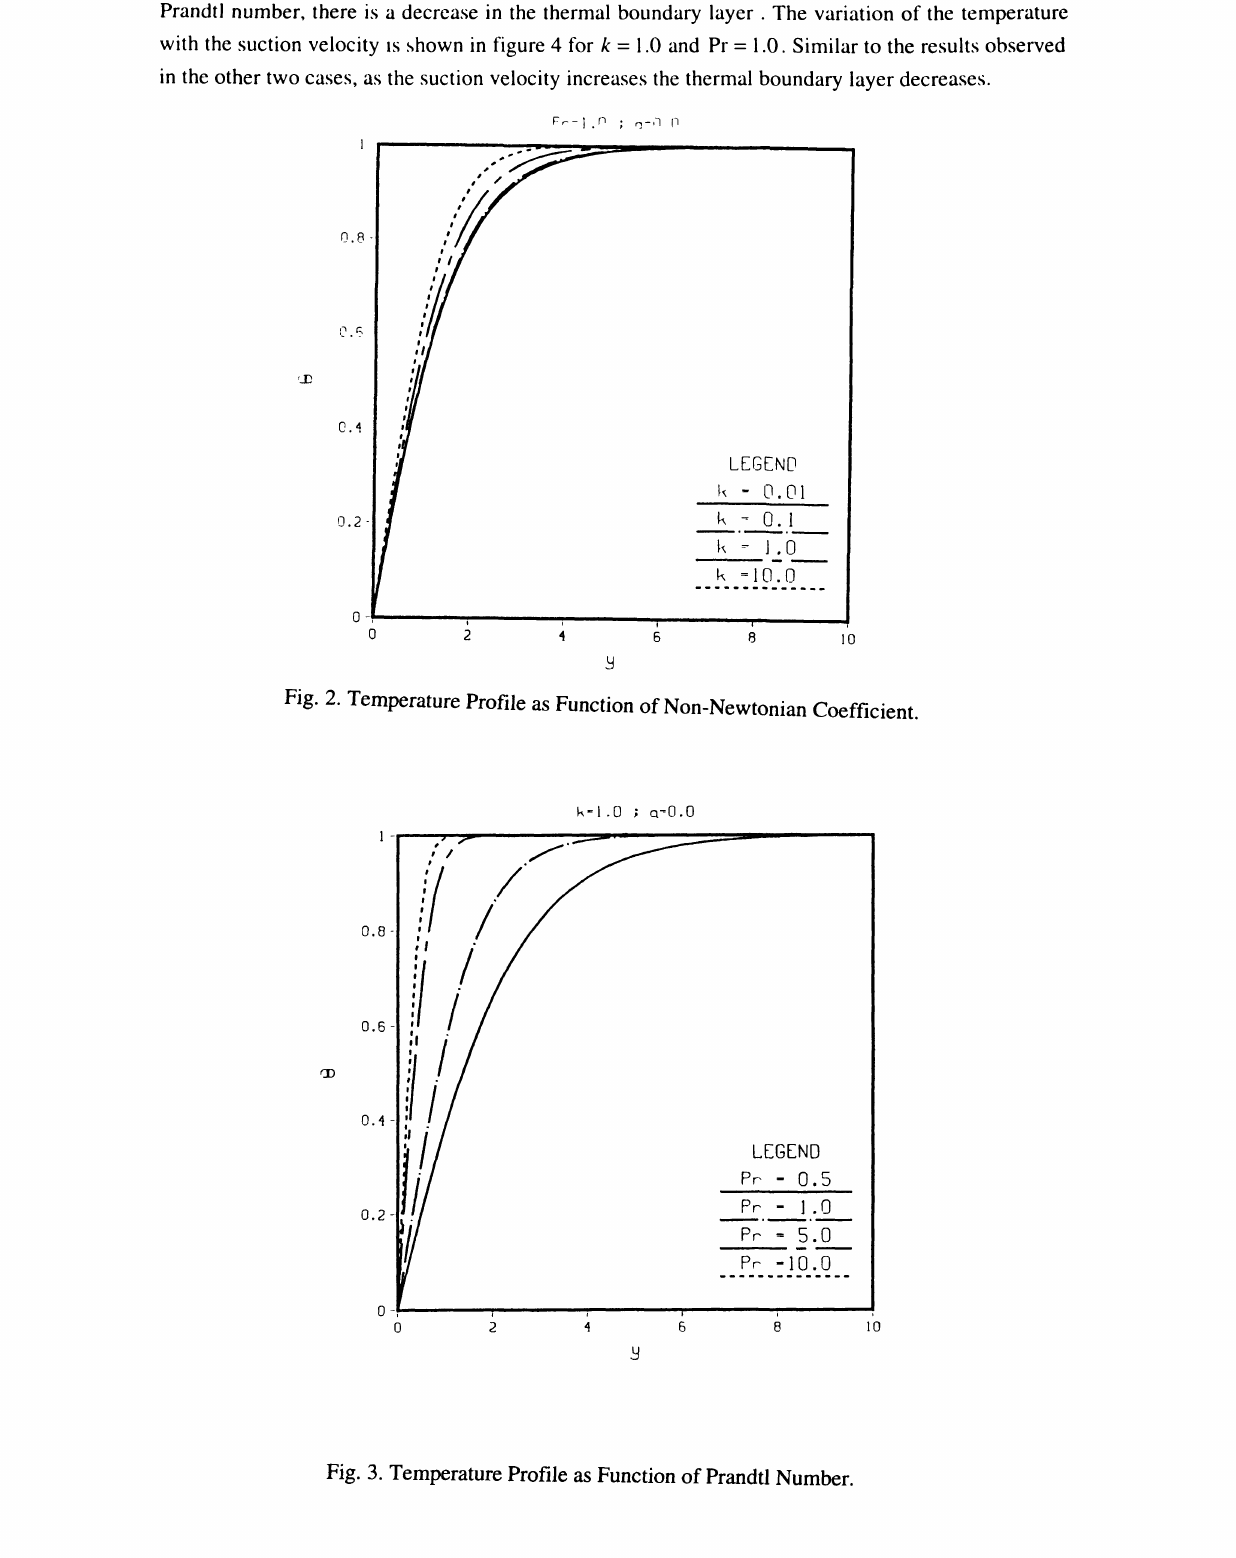
Fig. 2. Temperature Profile as Function of Non-Newtonian